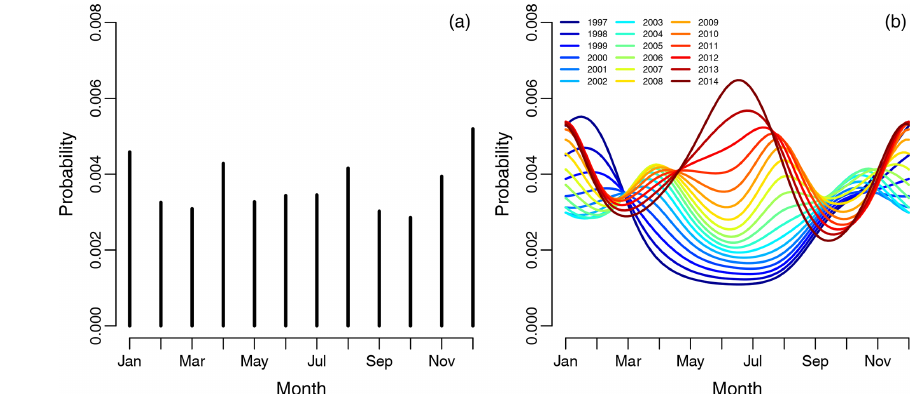
Figure 2. (a) Graph showing the empirical risk of revision for infection associated with each month and averaged over the years. Each vertical line represents 1 calendar month, with risk of revision due to infection as the dependent variable. Panel (b) shows the spline regression model, accounting for month-by-year interaction on the risk of infection. Each curve represents 1 year in the study period.